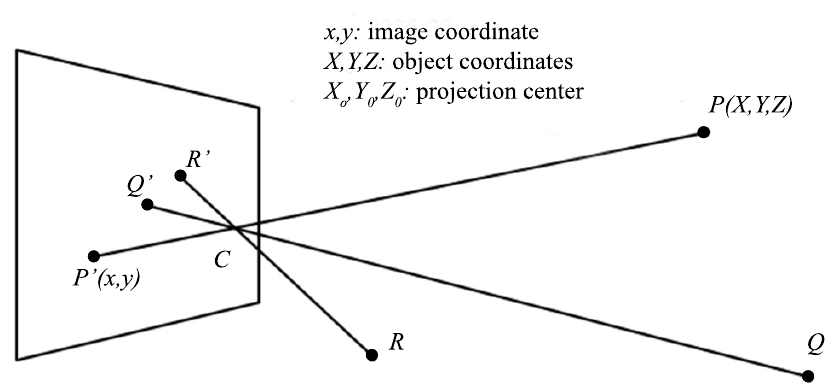
Figure 12. Collinearity